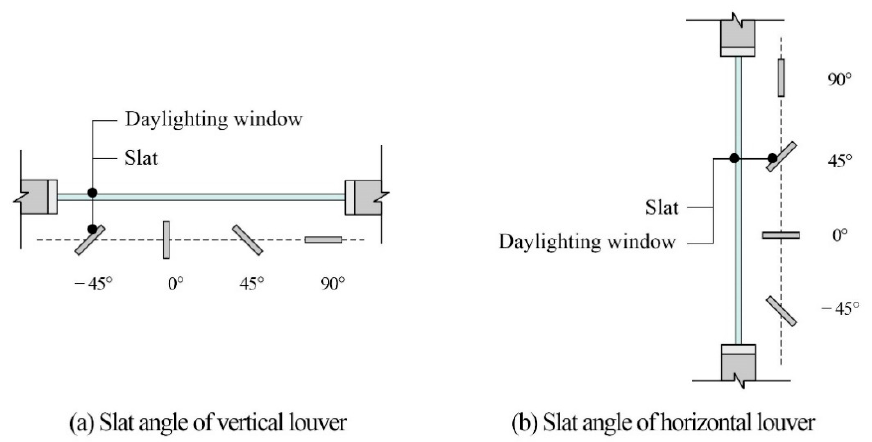
Figure 7. Slat angles of vertical and horizontal louvers: ( a ) Slat angle of vertical louver, ( b ) Slat angle of horizontal louver. Figure 7. Test specimens for performance evaluation: ( a ) fabrication of moving parts (profile), ( b ) awing installation.